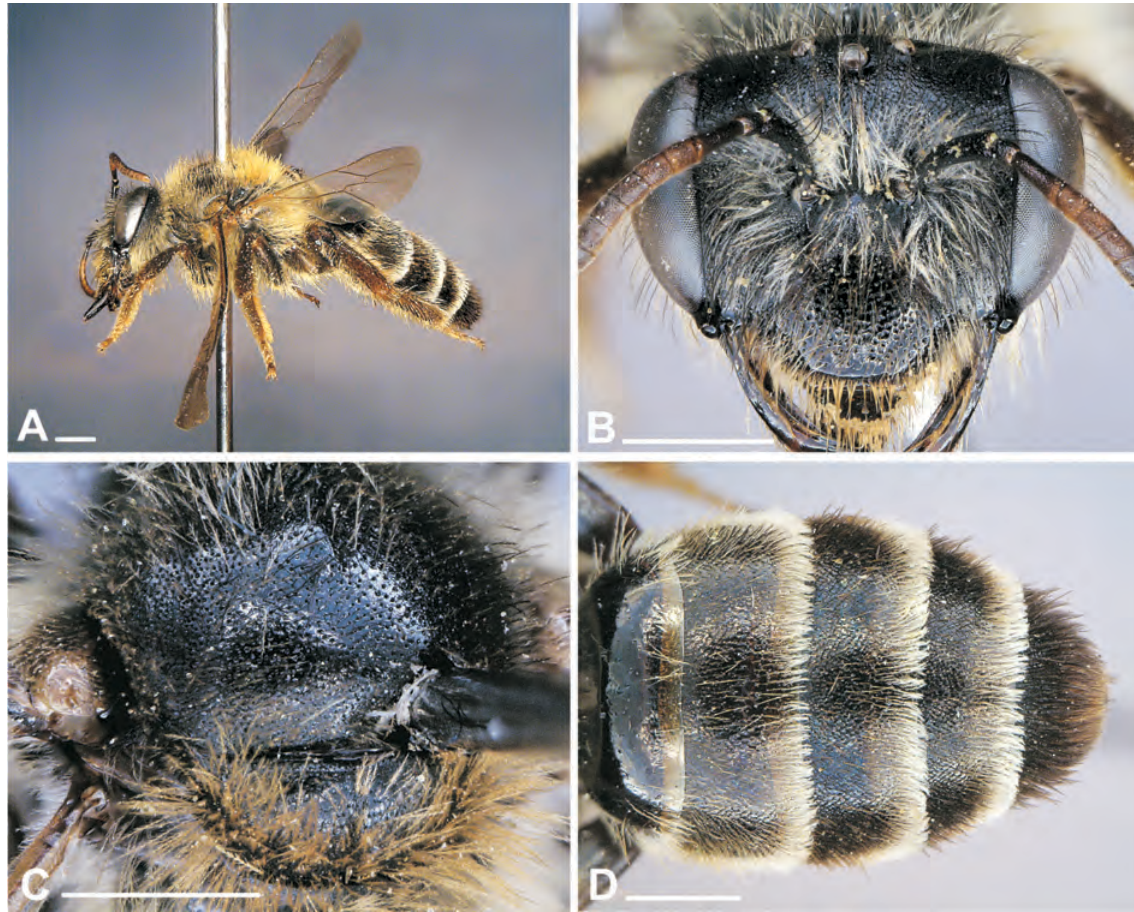
Fig. 7. Redivivoides karooensis sp. nov., ♀. A . lateral view. B . head. C . Scutum and scutellum. D . Metasoma (dorsal view). Scale bar: 1